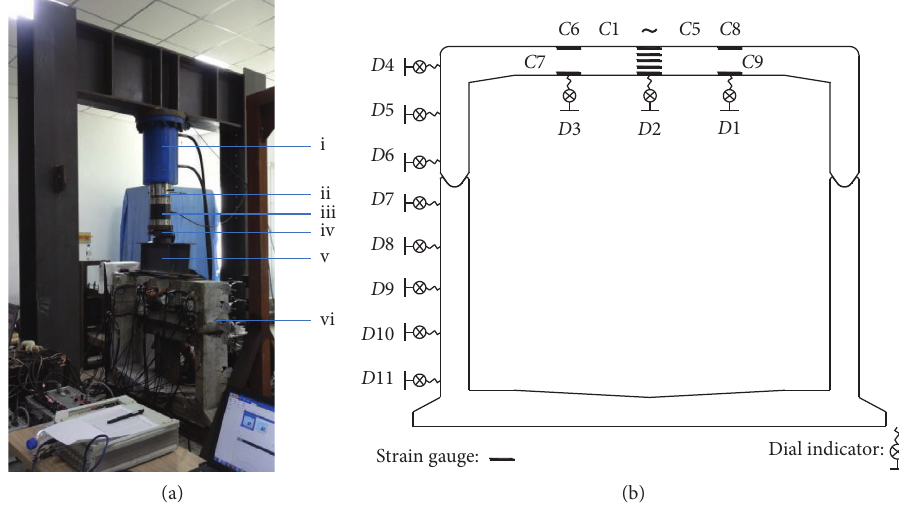
Figure 3: Loading and measuring. (a) The diagram of test loading. (i) Load cylinder. (ii) Stub column. (iii) Load cell. (iv) Leveling Device. (v) Load plate. (vi) Test specimen. (b) The arrangement of measuring